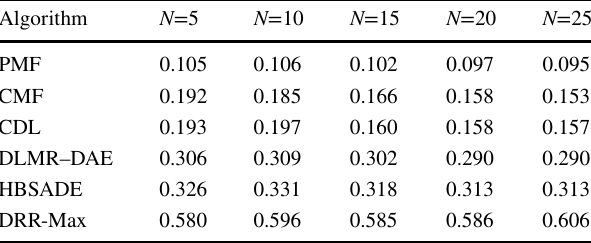
Table 6 F1 for Amazon-b data set Algorithm